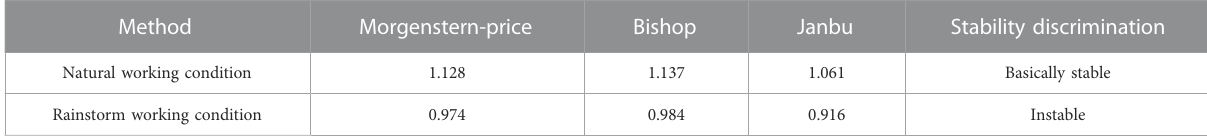
TABLE 4 Numerical simulation results of the safety coef fi